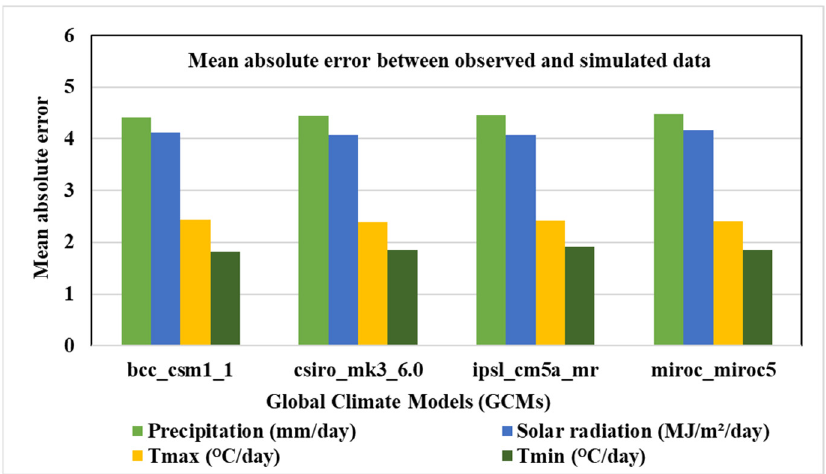
Figure 4. Comparison of mean absolute error for climatic factors with all the four global climate models.